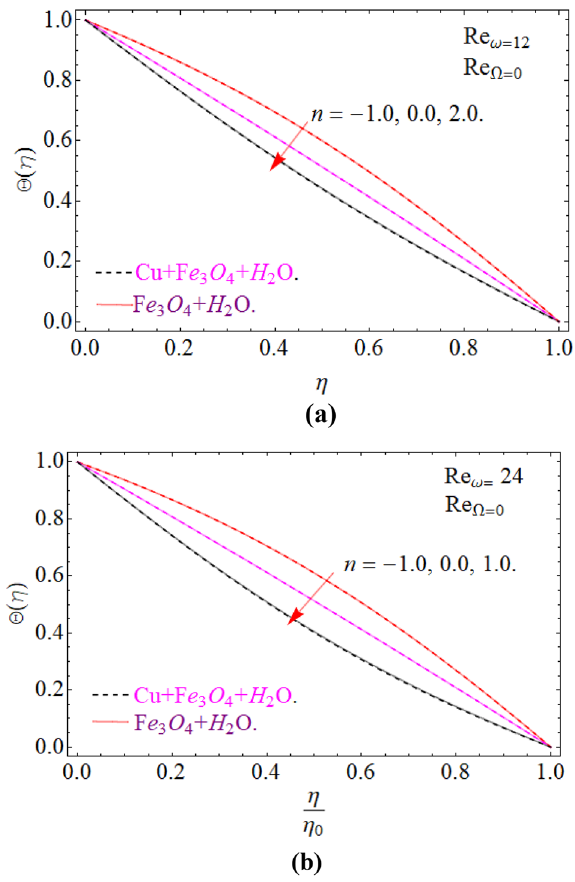
Figure 17. Impression of Θ( η ) amongst a stationary cone and rotating disk at three different radial exponents. ( a ) Re Ω = 12 and ( b ) Re Ω =